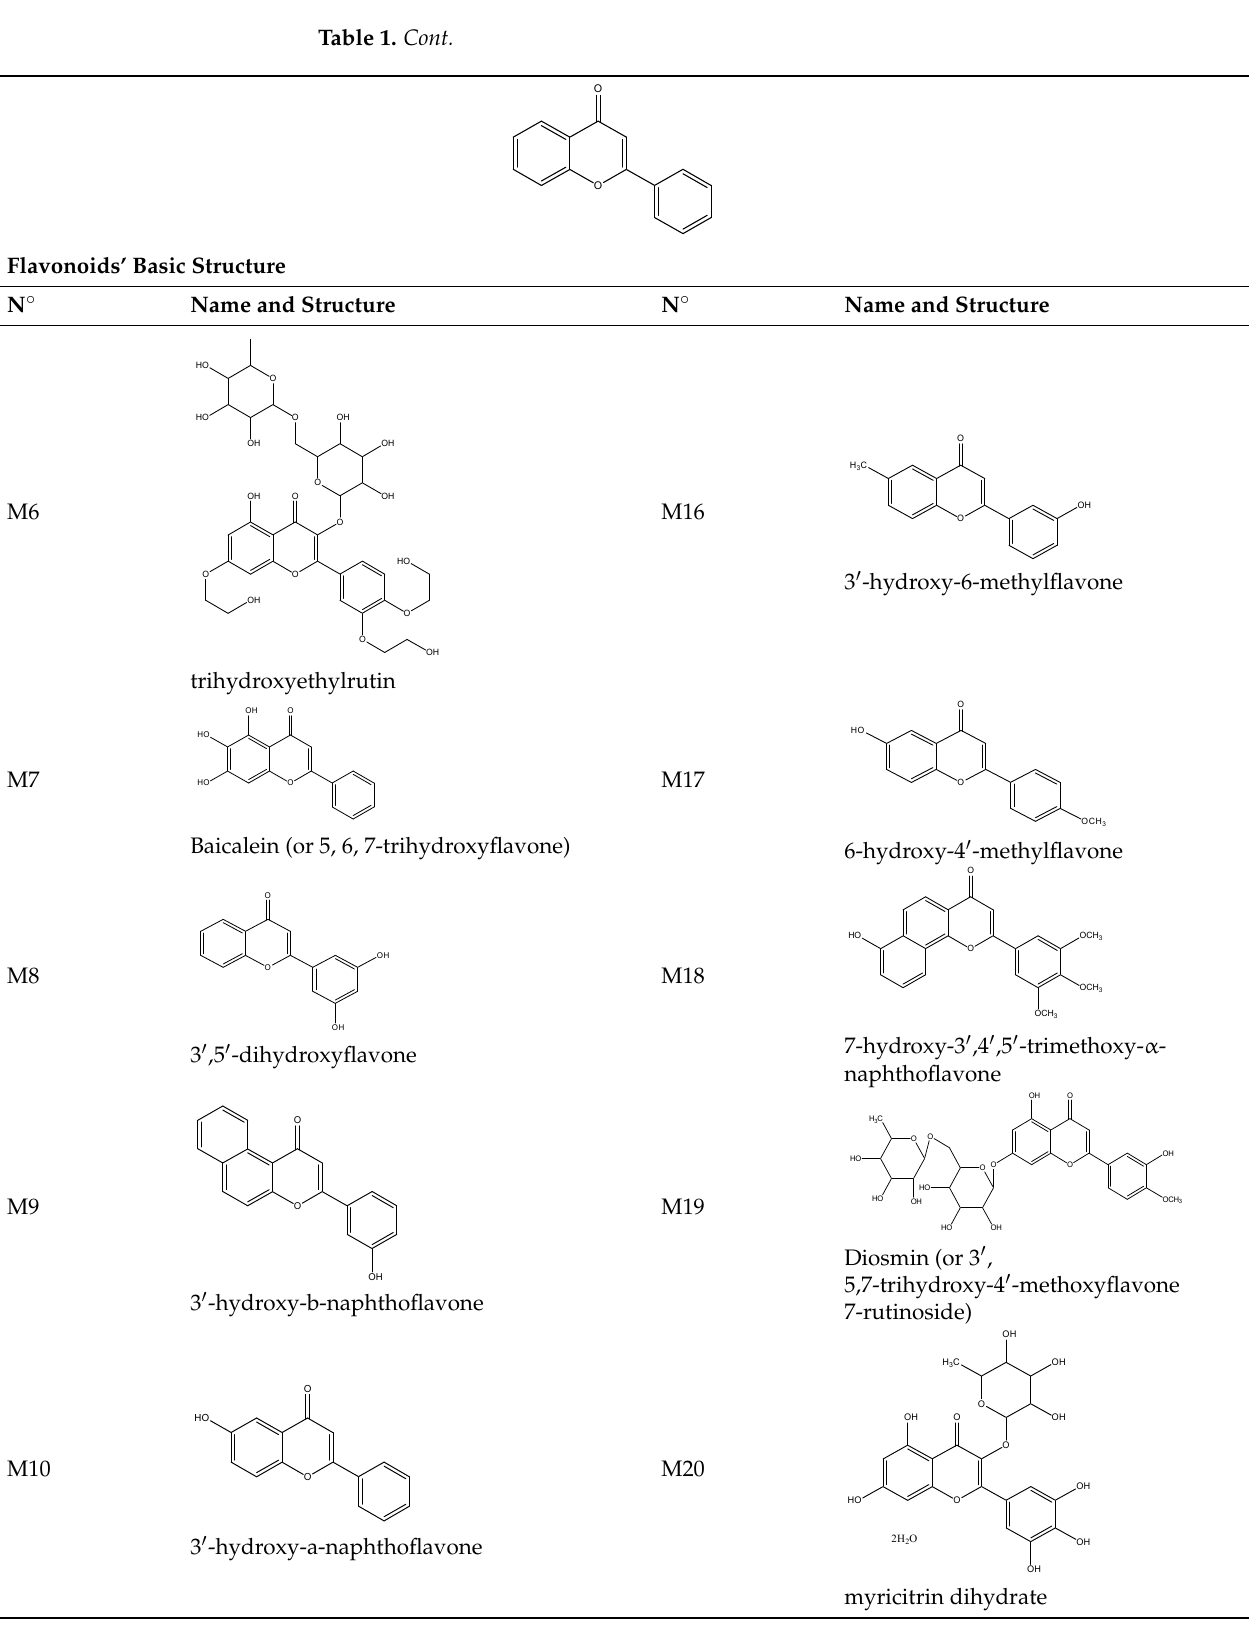
Table 1. Cont. Table 1. The flavone structure